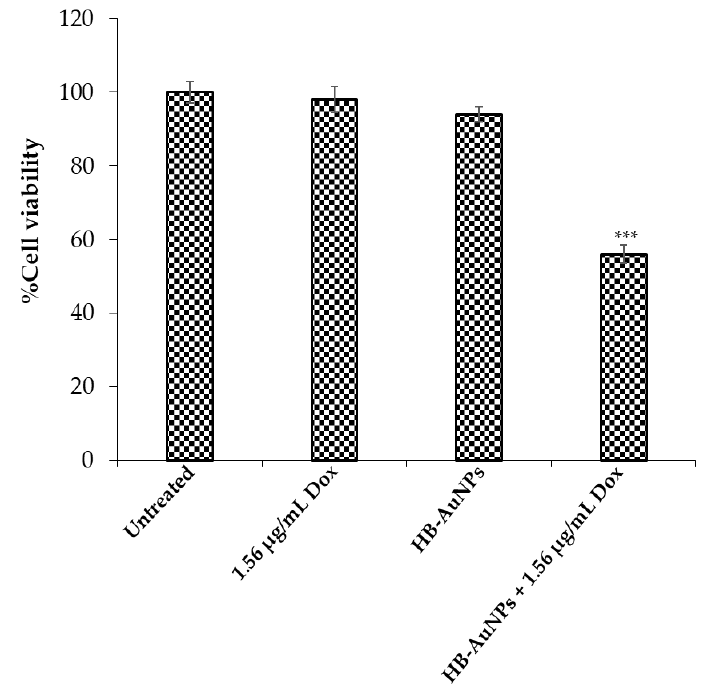
Figure 9. Co-treatment with 2 mg/mL_HB-AuNPs and Dox enhanced cell death in Caco-2 cells. Individual treatments demonstrated insignificant effect on the viability of Caco-2 cells after 24 h exposure, whereas combination of Dox (1.56 µ g/mL) and 2 mg/mL_HB-AuNPs (100 µ g/mL) significantly reduced cell viability. p ≤ 0.05 was considered as statistical significant for untreated vs. treated samples, *** p value =